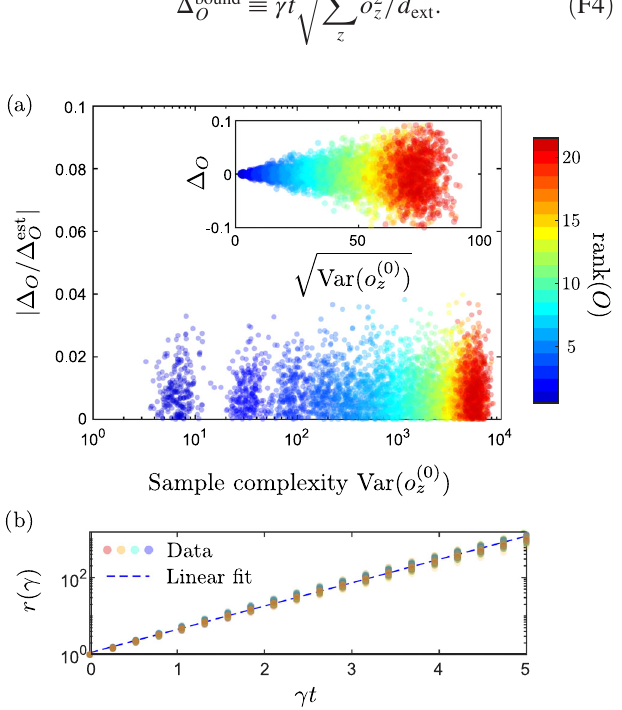
FIG. 10. The performance of our protocol in the extracting quantum state fidelity [Fig. 6(a)] in the presence of local dephasing noise. (a) In the first strategy, we process the data as if there were no experimental error. The main plot is between the exact systematic error Δ and the bound Δ bound in Eq. (43) as O O γ Þ a function of the sample complexity Var ð o ð z Þ (evaluated in a noiseless evolution). Each scatter point corresponds to a ran- domly chosen rank- k observable for k ¼ 1 ; … ; 21 . The initial 6 , Δ ¼ − Ω , V 0 . state is the ground state of H with n 2 ¼ Ryd syst ¼ We extract the expectation values of the observables by evolving the extended system, including 7 ancillas in the global setup [Fig. 6(a)], for time t ¼ 12 π = Ω under the noisy channel described in Eq. (F1) at γ t ¼ 0 . 02 , Δ ¼ − Ω , and V 2 ¼ 0 . 2 Ω . The inset plots the systematic error versus the noiseless sample complexity M , confirming our prediction that low-sample-complexity O observables are also more robust against noise. (b) In the second strategy, we instead take the error model into account in processing the measurement snapshots. We plot the ratio r ð γ Þ γ Þ between the noisy sample complexity Var ð o ð z Þ and its noiseless version Var ð o ð o Þ z Þ as a function of γ t . The overlapping scatter points correspond to random observables of ranks between one 21 . The dashed line is a linear fit to the mean ratio as a and d syst ¼ function of γ t in the log-linear